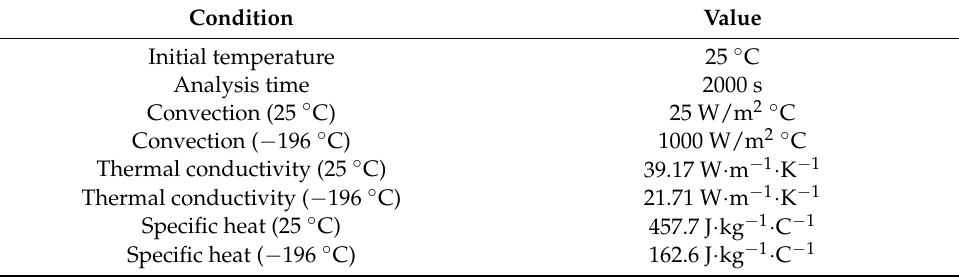
Table 2. Boundary conditions and material properties for the.